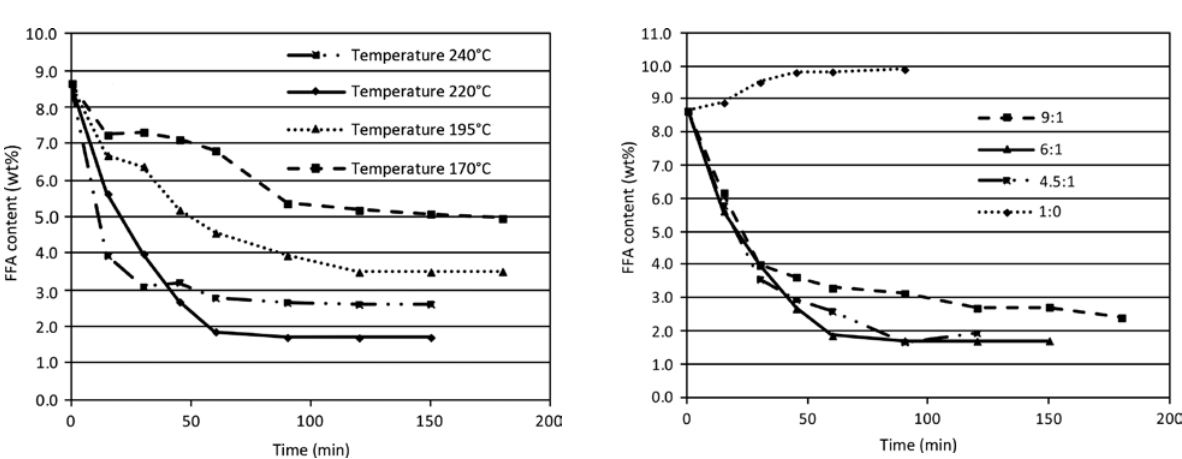
Figure 3: Influence of temperature on reaction speed and equilib- rium conversion of free fatty acid (FFA) (oil:glycerol mass ratio = 6:1 and p = 3 bar).